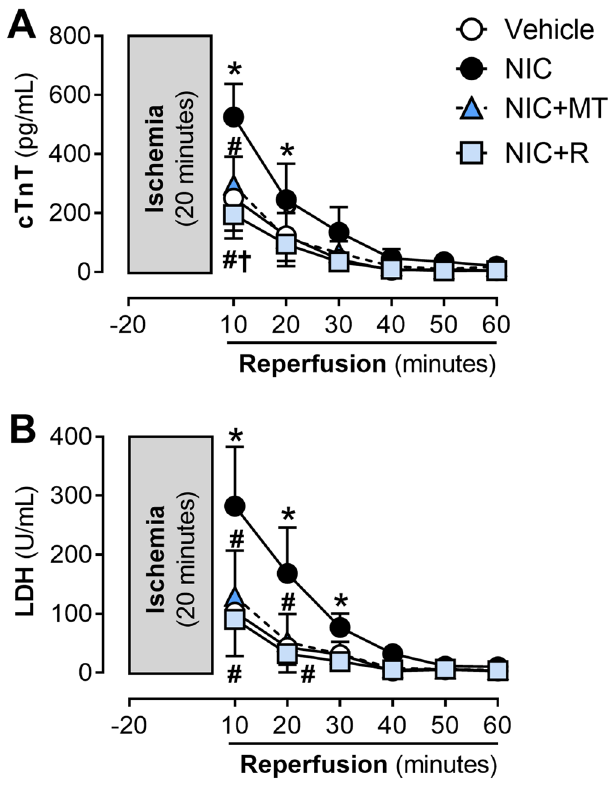
Figure 6. Time course for post-ischemic release of cardiac injury markers, ( A ) cTnT and ( B ) LDH in coronary effluent from Langendorff-perfused rat hearts isolated from the vehicle, NIC, NIC + MT, and NIC + R. All values are given as mean ± SEM for n = 6–8/group; * p < 0.05 versus vehicle group; # p < 0.05 versus NIC group and † p < 0.05 versus NIC + MT group using two-way ANOVA with repeated